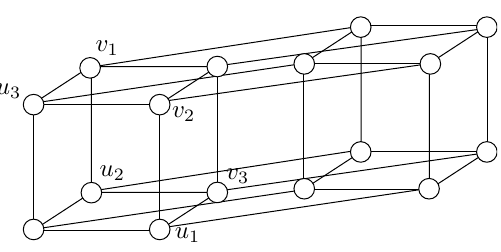
Fig. 1: The only non-connectable odd family of three pairs of vertices of Q